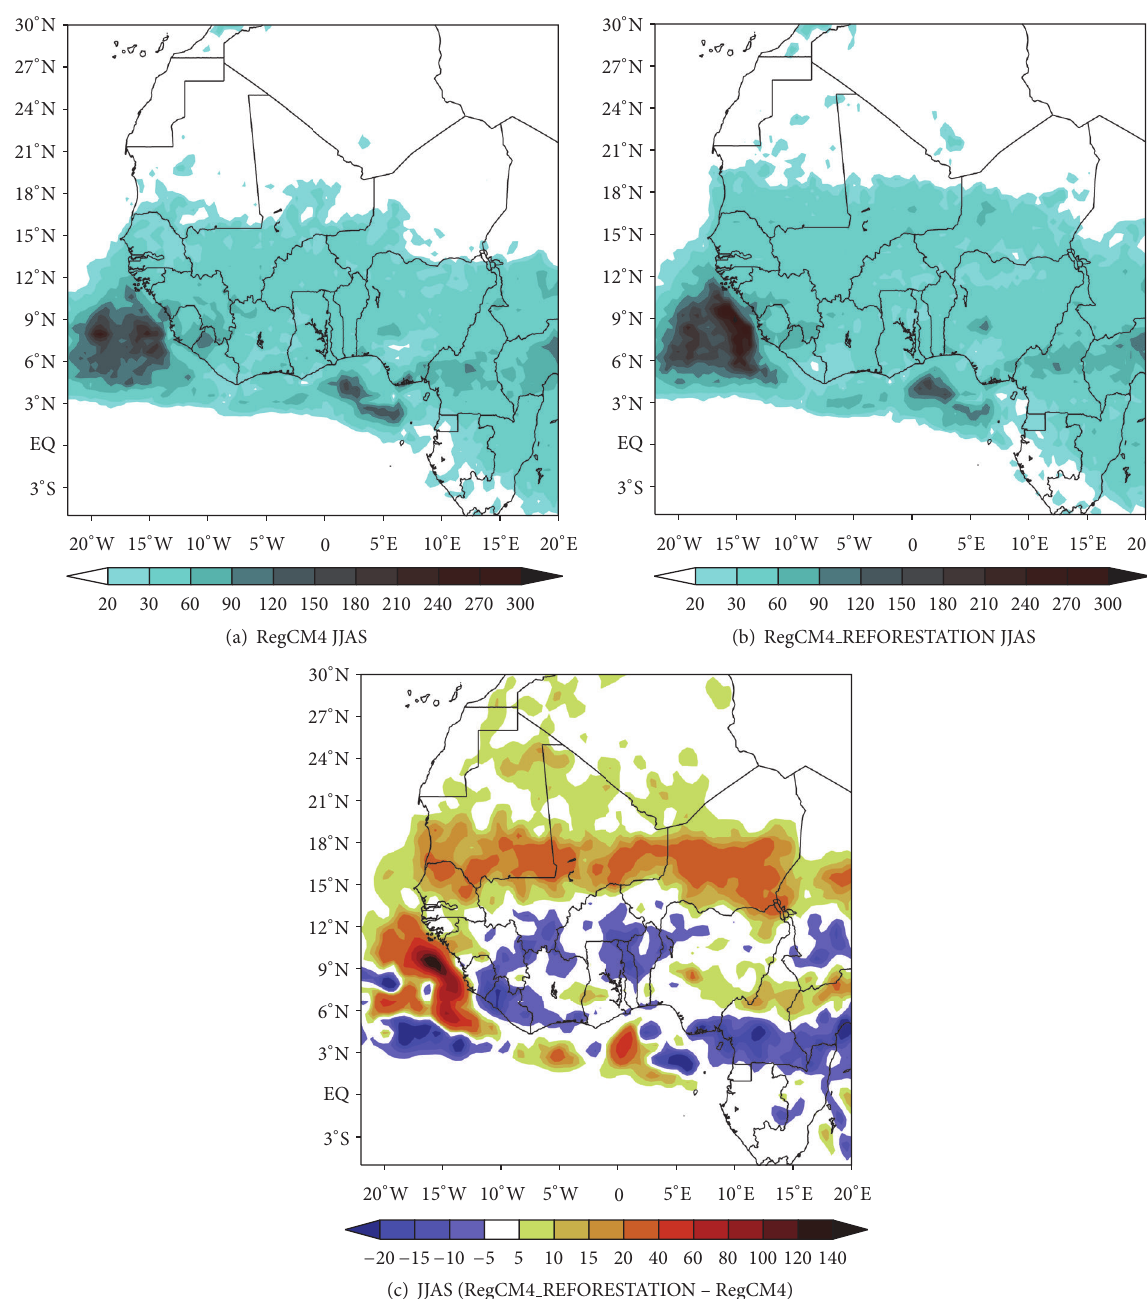
Figure 14: Mean JJAS 99th percentile of daily rainfall events (mm/day) over West Africa for both runs and their difference averaged from 2003 to